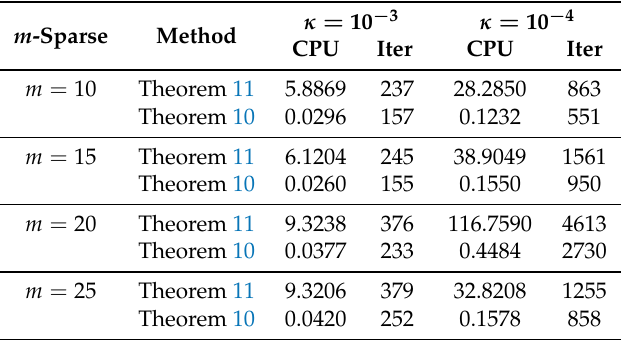
Table 5. Numerical results for the LASSO problem in case M = 512, N = 256.